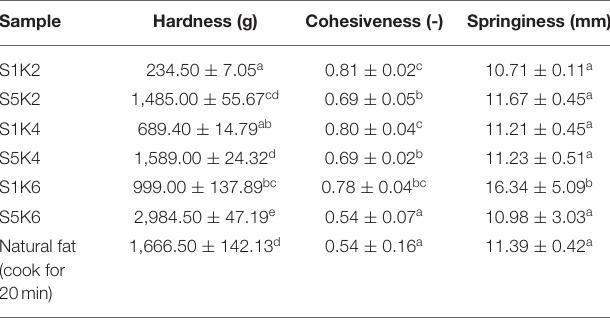
TABLE 3 | The TPA of the fat substitutes with different protein and konjac content levels and natural meat fat.